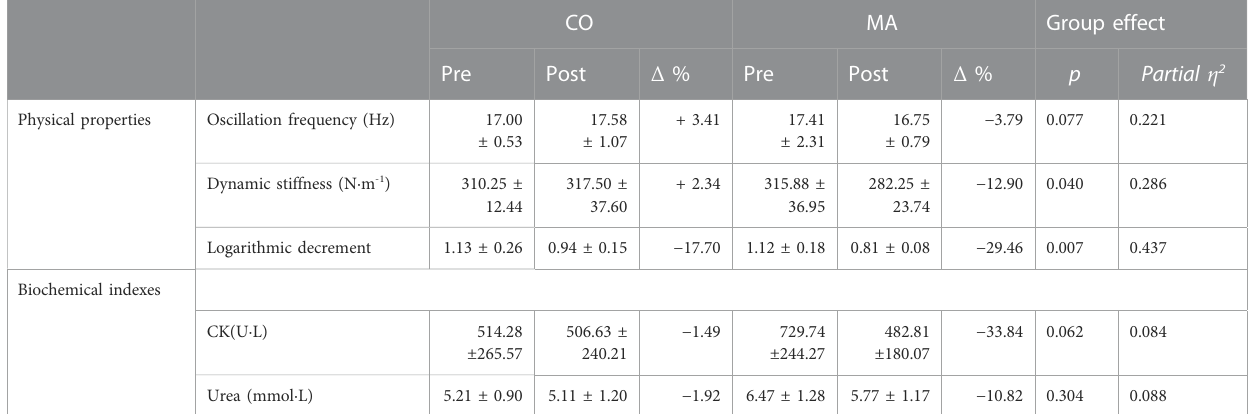
TABLE 1 In fl uence of machine massage on muscle physical properties and serum biochemical indexes after intervention. CO MA